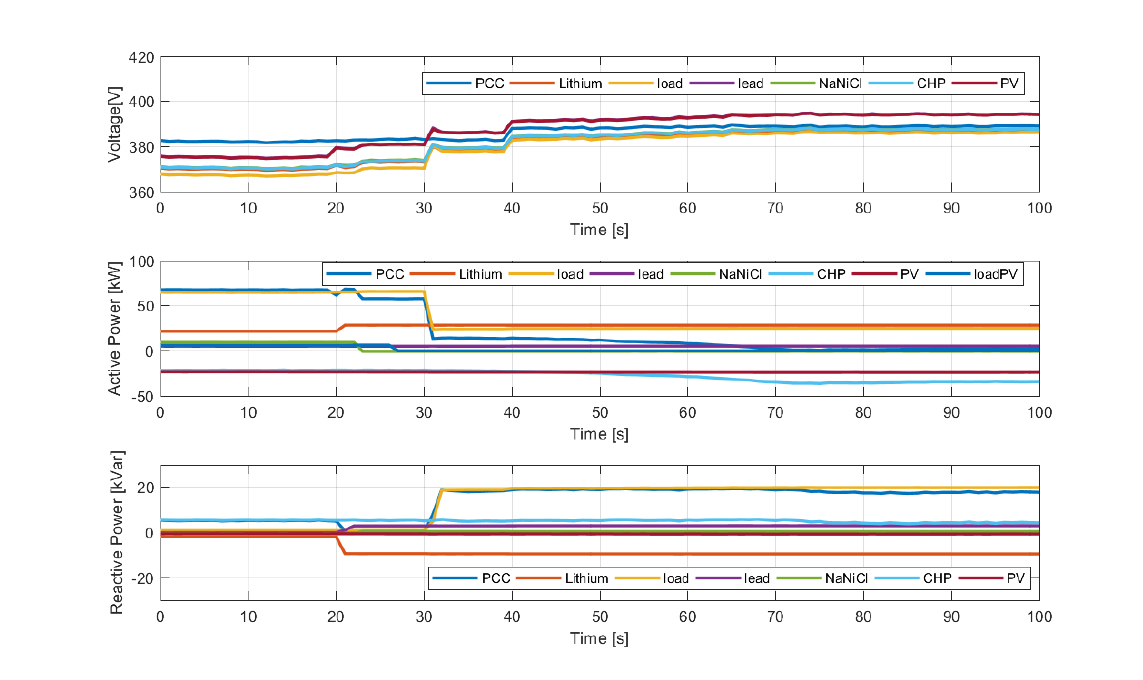
Figure 5. Voltage magnitudes in test system over time and active and reactive power outputs in undervoltage condition and with the control of all the resources.